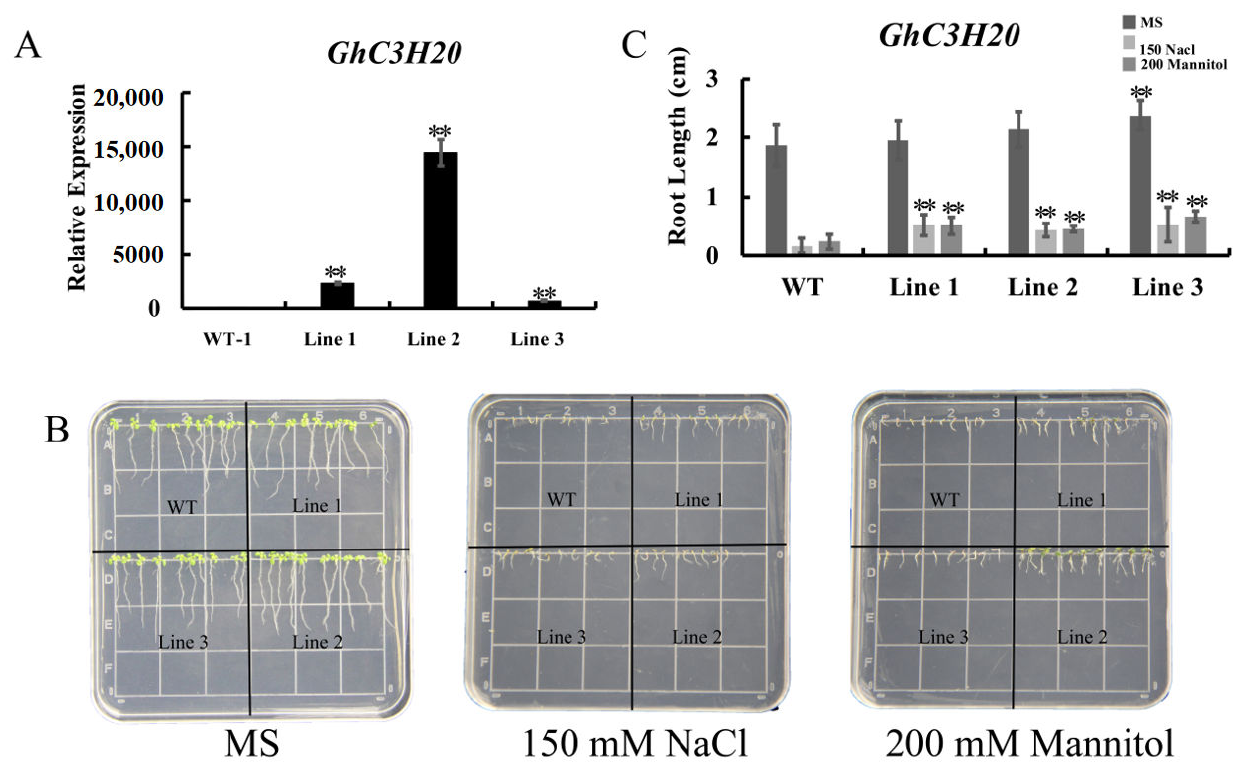
Figure 4. Overexpression of GhC3H20 enhanced salt and osmotic stresses tolerance in Arabidopsis seedlings. ( A ) The expression levels of GhC3H20 in WT Arabidopsis and three transgenic Arabidopsis lines. ( B ) Root length phenotype of WT Arabidopsis and three transgenic Arabidopsis lines under 1/2 MS medium, 150 mM NaCl, and 200 mM mannitol treatments. ( C ) Statistics of root lengths of Arabidopsis thaliana seedlings under salt and osmotic stresses. The error bars represent standard deviations of three technical replicates or standard deviations of the root length among Arabidopsis seedlings (** p < 0.01, Student’s t -test). Note: WT represents wild-type Arabidopsis . Line 1, Line 2, and Line 3 represents three transgenic Arabidopsis lines.